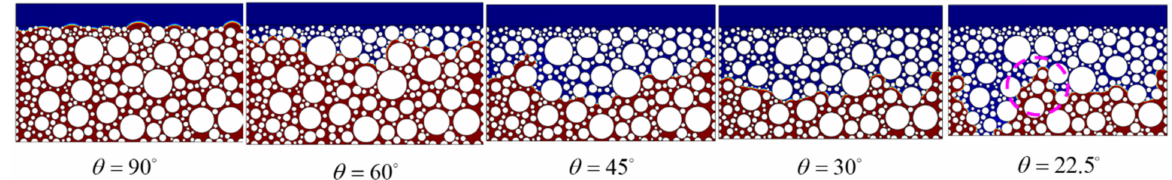
Figure 15. Oil-water distribution at the end of imbibition with different contact